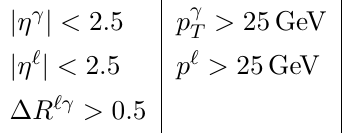
Table 8 . Fiducial cuts imposed for calculations of the total rate at 13